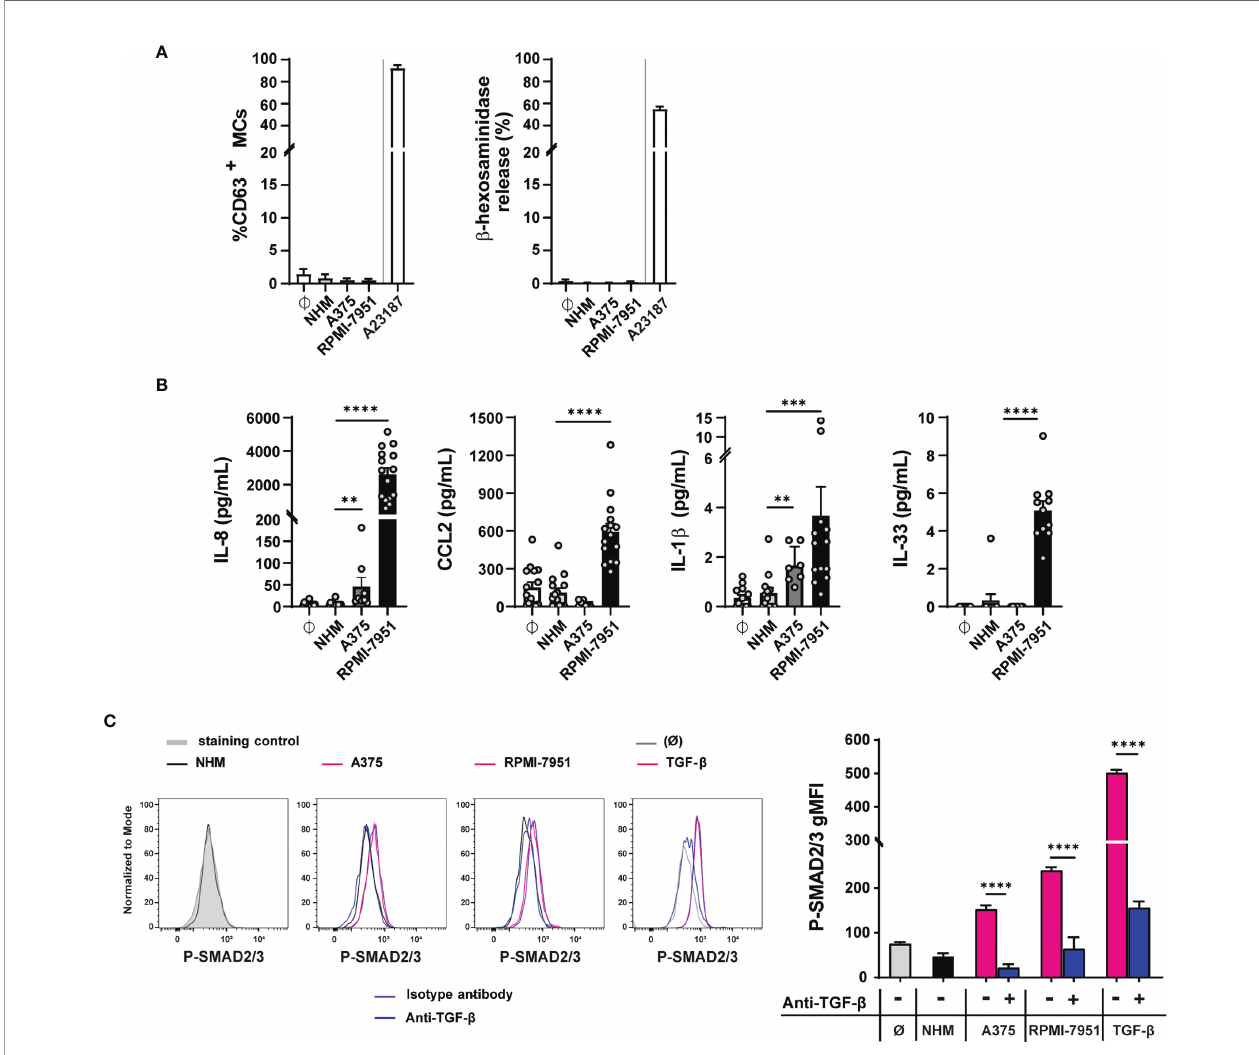
FIGURE 4 | Melanoma cell-secreted mediators do not induce MC degranulation but cytokine production and TGF- b -mediated signaling. Blood-derived human mast cells were incubated 50% v/v with human melanocytes (NHM), A375 (A375), and RPMI-7951 (RPMI-7951) cell culture supernatants or with medium (Ø). (A) After 1 h, MC degranulation was assessed by CD63 surface staining, measured by fl ow cytometry or b -hexosaminidase release assay. Calcium ionophore A23187 was used as positive control. Data shown as mean ± SEM of four independent experiments. (B) After 48 h, cytokine levels were quanti fi ed in MC pellets by cytometric bead array (CBA) for IL-8, CCL2, and IL-1 b and by ELISA for IL-33. Data shown are the average ± SEM of at least four independent experiments ( n = 7 – 15). ** p < 0.01, *** p < 0.001 using the one-way ANOVA statistical test. (C) After 90 min, SMAD2/3 phosphorylation was measured by intracellular fl ow cytometry staining: as positive control, MCs were treated with TGF- b 1 (5 ng/ml), and for negative control, MCs were left untreated (Ø). In (C) , the dotted gray histogram shows the isotype control staining and the black line represents MCs treated with NHM culture supernatant cells. The pink lines show the A375 culture supernatant, RPMI-7951 culture supernatant, or TGF- b treatment. In addition, MCs were incubated with the TGF- b blocking antibody, anti-human TGF- b 1, 4D11 (100 µg/ml) (anti-TGF- b , blue line), or the isotype blocking antibody (isotype antibody, purple line). On the right, the graph shows the phosphoSmad2/3 geometric mean fl uorescence intensity (gMFI) in the different conditions. The data are representative of three independent experiments. Each bar indicates mean ± SEM from three samples (**** p < 0.0001 using the two-way ANOVA and Sidak ’ s multiple comparisons test, comparing the TGF b blocking-treated sample to its matched untreated